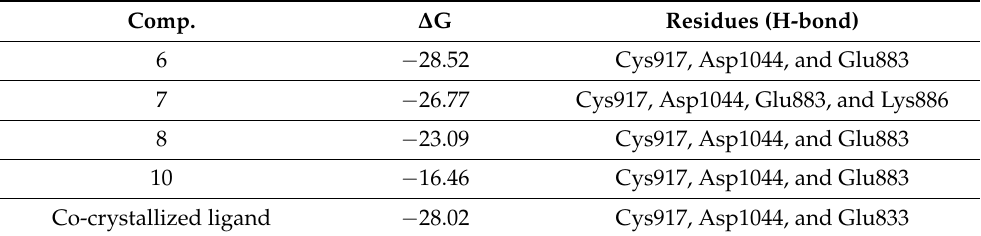
Figure 8. Binding pattern of compound 7 forming five H ‐ bonds with Cys917, Asp1044, Glu883, and Lys886 in addition to many hydrophobic interactions with Phe1045Ile886 and Val897.